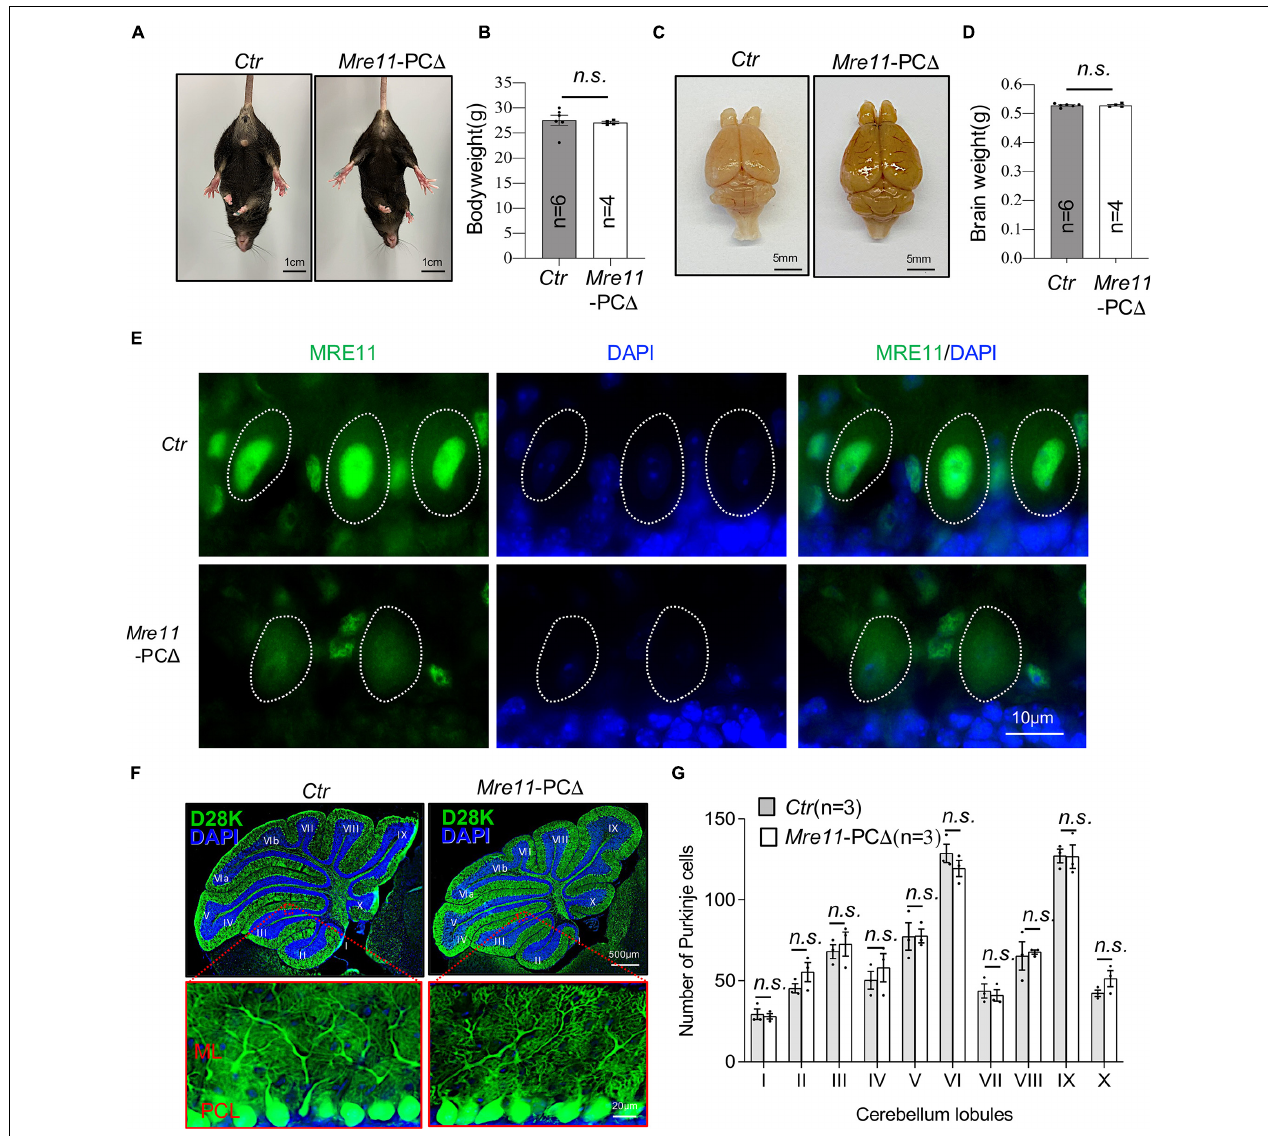
FIGURE 4 | Normal brain and the cerebellum of Mre11 -PC (cid:49) mice. (A) Abdominal view of wild type ( Ctr ) and Mre11 -PC (cid:49) mice showed normal limbs stretching. (B) Bodyweight of control ( Ctr ) and Mre11 -PC (cid:49) mice at 18 months of age. The number of mice analyzed is indicated within the graph bars. Error bars indicate the value mean ± SEM; n.s., not significant; data comparison was performed through Student’s t -test. (C) A dorsal view of the whole brain of control ( Ctr ) and Mre11 -PC (cid:49) mice. (D) Brain weight of 12-month-old Ctr and Mre11 -PC (cid:49) mice. The number of mice analyzed is indicated within the graph bars. Error bars indicate the value mean ± SEM; data comparison was performed by Student’s t -test. n.s., not significant. (E) Sagittal cryosections of 18-month-old Ctr and Mre11 -PC (cid:49) mice after staining with anti-MRE11 antibody and DAPI. Note a reduction of MRE11 signal in mutant Purkinje cells. The Purkinje cell layer in the cerebellum region is shown. Dotted lines highlight the nucleus of Purkinje cells. (F,G) Mre11 -PC (cid:49) mice have normal density and morphology of Purkinje cells. Sagittal sections of control ( Ctr ) and Mre11 -PC (cid:49) mice were stained with Calbindin-D28K (D28K) antibody (green) and DAPI (blue) to label Purkinje cells and nuclei, respectively (F) . The upper panels show the whole cerebellum, and the lower panels show the magnified view of red frames in the respective upper panels. ML, molecular layer; PCL, Purkinje cell layer. (G) Quantification of total Purkinje cell number in each individual cerebellar lobule from panel (F) . Three mice of each genotype were analyzed. Error bars indicate the value mean ± SEM; data comparison was performed through Student’s t -test. n.s., not